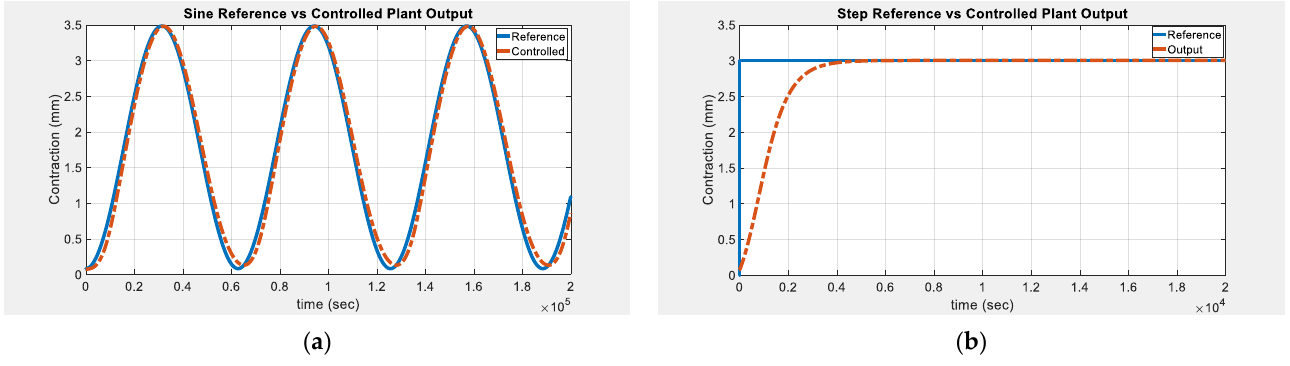
Figure 13. PI-controlled PAM simulation against a reference.: ( a ) sinusoidal reference; ( b ) step reference.